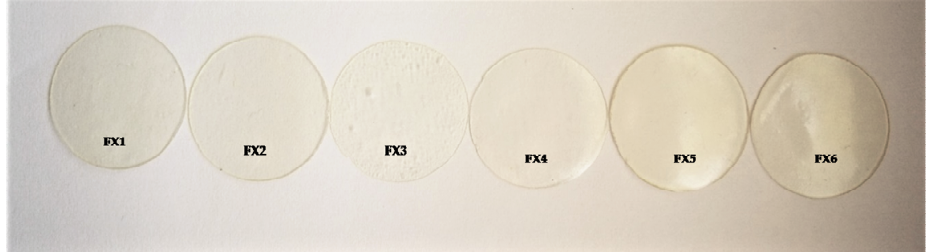
Figure 3. The physical appearance of the prepared orodispersible films with FX.